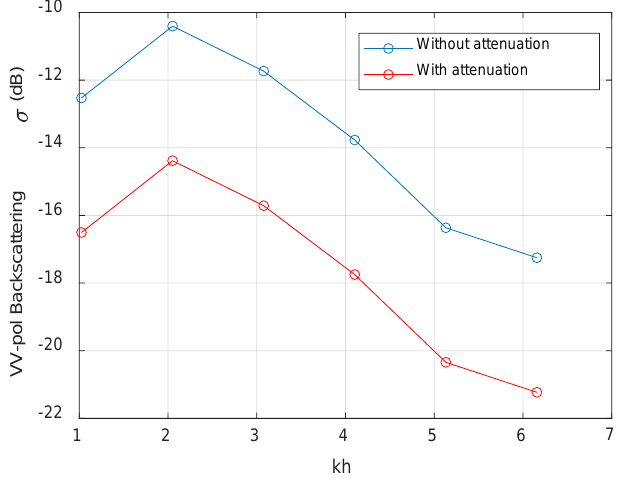
Figure 19. Backscattering as a function of kh for rough surfaces with “constant correlation length”. The upper medium is snow with permititivy of 1.44 and the lower medium is soil permittivity of 5.5 + 2i. The red curve is with snow attenuation and blue curve without snow attenuation.